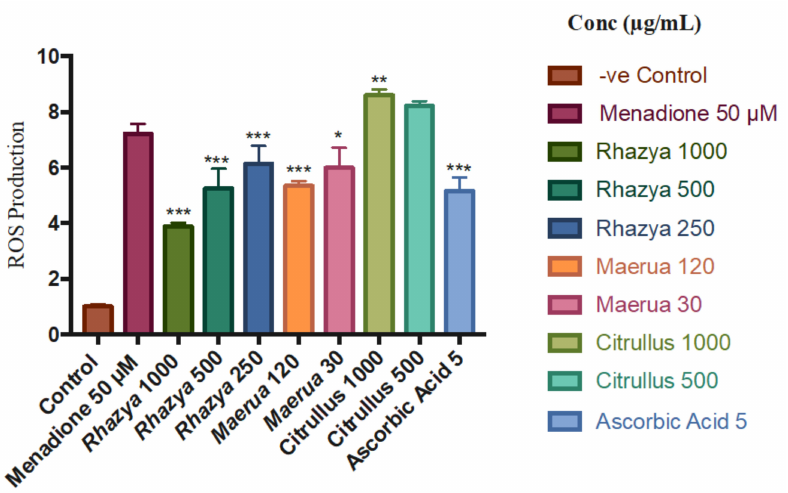
Figure 6. A comparison of the different plant extracts’ ROS production compared to the control and menadione ( µ g/mL) (mean ± S.D.). The results were obtained through three independent experiments. Statistical analysis of significant changes compared to the control (* p < 0.05, ** p < 0.01, and *** p < 0.001).